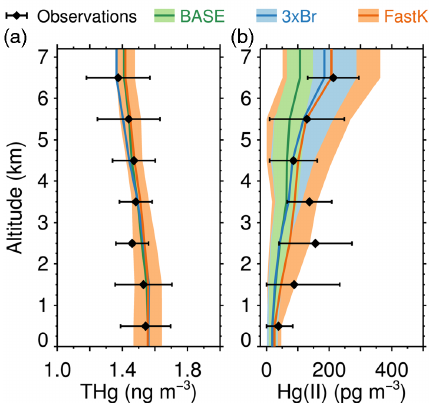
Figure 4. Mean vertical profiles of (a) THg and (b) Hg(II) con- centrations averaged in 1km vertical bins during NOMADSS. Ob- servations are shown with black diamonds (error bars indicate the standard deviation). BDL Hg(II) observations are estimated using the ROS method for each vertical bin. The means and standard devi- ations for the three model simulations are shown as lines and shad- ing: BASE (green), 3 × Br (blue), and FastK (orange).